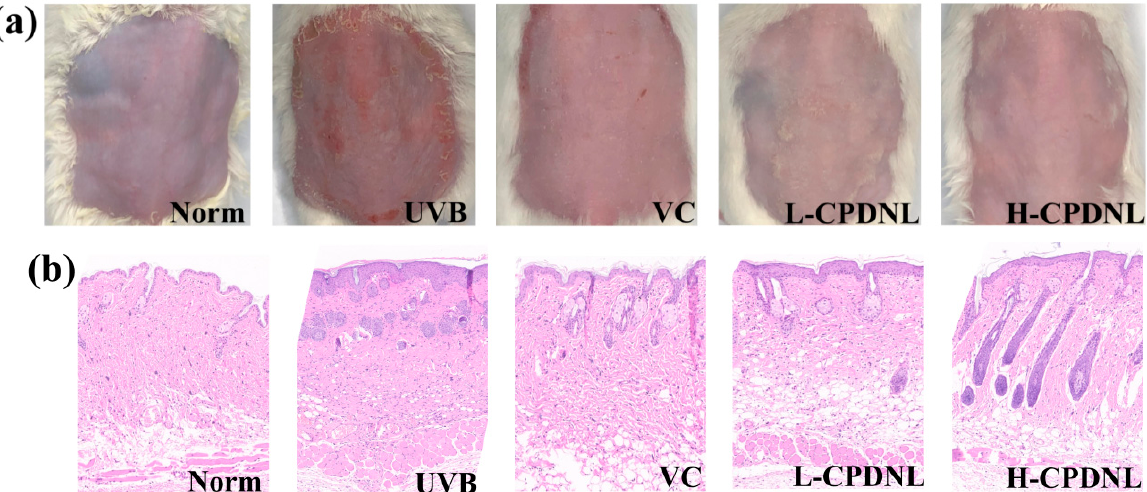
Figure 4. The external appearance and histopathology of skin tissues. ( a ) Images for the dorsal skin of mice; ( b ) hematoxylin and eosin (H&E) pathological images of skin. VC: vitamin C group; L-CPDNL: low-dose nanoliposomes of CPD photolyases; H-CPDNL: high-dose nanoliposomes of CPD photolyases.